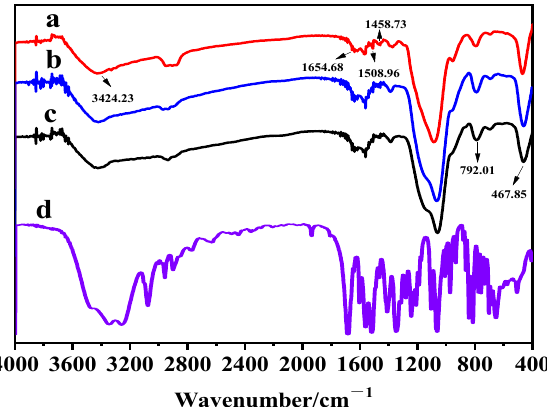
Figure 3. FT-IR spectra of MIP@SiO 2 @CAP ( a ), MIP@SiO 2 @QDs ( b ), NIP@SiO 2 @QDs ( c ) and CAP ( d ).